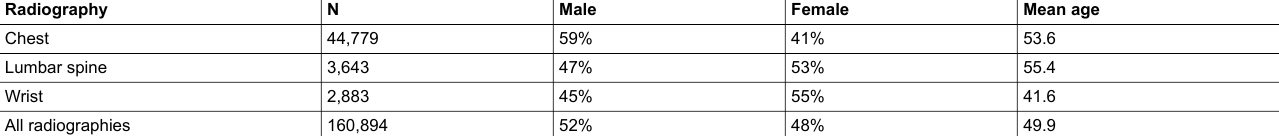
Table 4: Some characteristics of the sex and age distributions concerning the radiographies performed at CHUV in